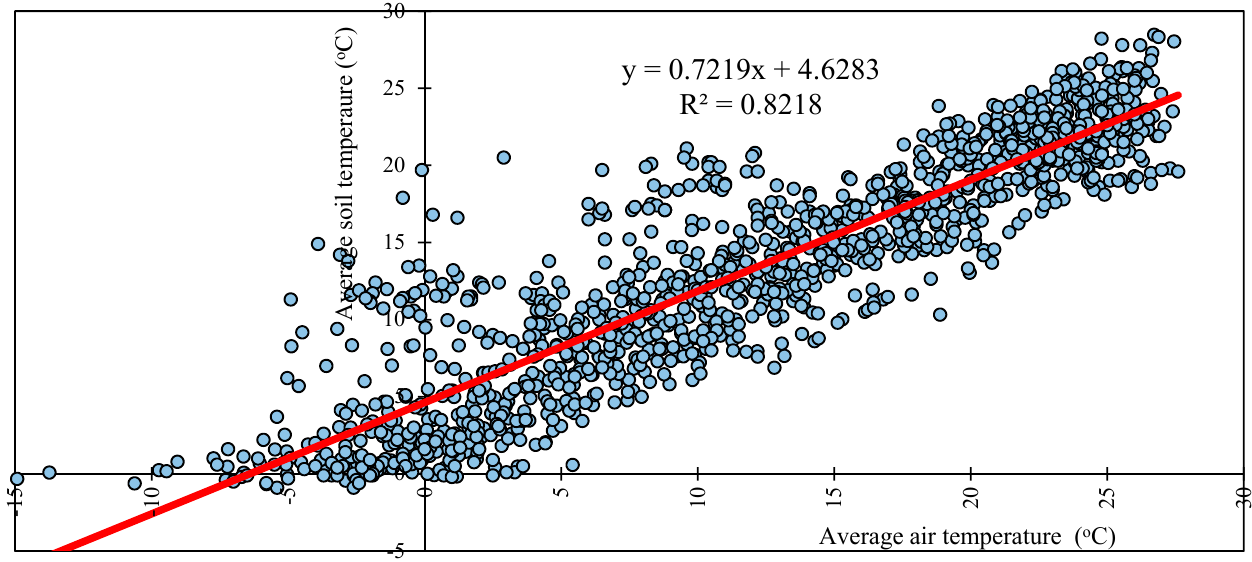
Figure 4. Relationship between mean daily air temperature and the soil temperature (average upper 10 cm soil layer) during the 2018–2021 period at the experiment station. Table 1. Summary of the analysis of variance of crop monthly and seasonal